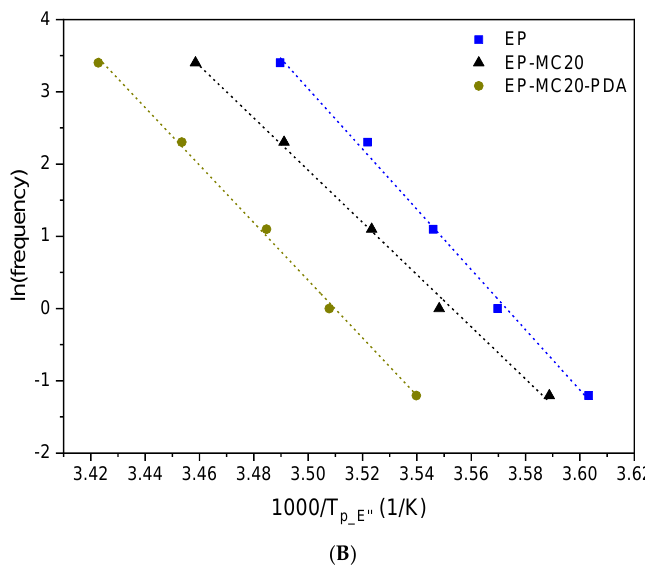
Figure 7. Results of the DMA multifrequency scans on the samples EP, EP-MC20, and EP-MC20-PDA. Investigated frequencies: 0.3–1–3–10–30 Hz. ( A ) DMA thermograms with trends of E (cid:48) , E (cid:48)(cid:48) , and tan δ . ( B ) Natural logarithm of frequency as a function of 1000 / T p _ E (cid:48)(cid:48) . The dashed lines represent the result of